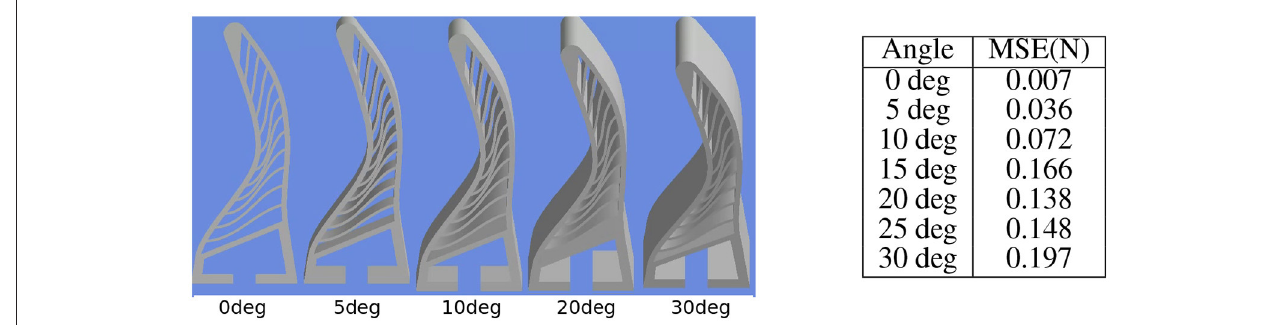
FIGURE 14 | Effect of viewpoint variation on the approach. (Left) Input deformation images from FEA by varying camera pitch. (Right) . Mean squared error in force predictions encountered by the approach on the test set without any retraining. It can be seen that the approach is able to tackle pitch difference of 10 ◦ without